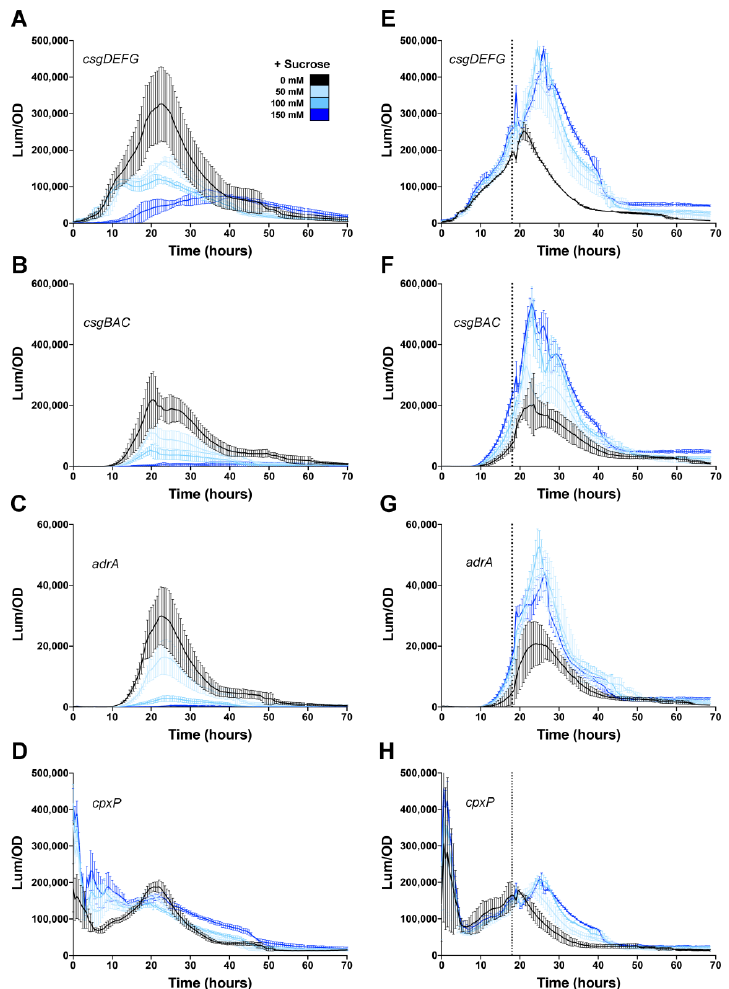
Figure 3. Effect of sucrose addition on the Salmonella csgD regulatory network. Expression of csgDEFG ( A , E ), csgBAC ( B , F ), adrA ( C , G ), and cpxP ( D , H ) operons was measured during growth of S. typhimurium 14028 at 28 ◦ C in media premixed with 50, 100 or 150 mM sucrose ( A – D ) or with sucrose added during growth ( E – H ; vertical line represents the time of addition at 18 h). For each graph, luminescence (light counts per second) divided by the optical density at 600 nm (Lum / OD) is plotted as a function of time and each curve represents a single growth condition. The mean and standard deviations are plotted from three biological replicate experiments measured in